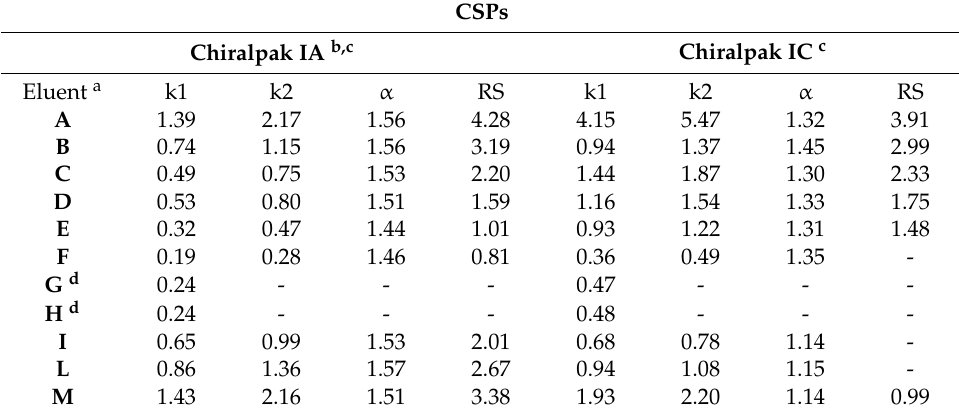
Table 1. a Eluent composition: A, n -Hex / IPA (90:10 v / v ); B, n -Hex / IPA (85:15 v / v ); C, n -Hex / IPA (80:20 v / v ); D, n -Hex / IPA (75:25 v / v ); E, n -Hex / IPA (70:30 v / v ); F, n -Hex / IPA (50:50 v / v ); G, IPA (100); H, EtOH (100); I, n -Hex / EtOH (80:20 v / v ); L, n -Hex / EtOH (85:15 v / v ); M, n -Hex / EtOH (90:10 v / v ); b Mobile phase was added with 0.1% DEA; c Mobile phase was added with 0.3% TFA; Flow rate: 1.0 mL / min; d Flow rate: 0.5 mL / min; Concentration: 1 mg / mL; Injection volume: 10 µ L; UV detection at 220